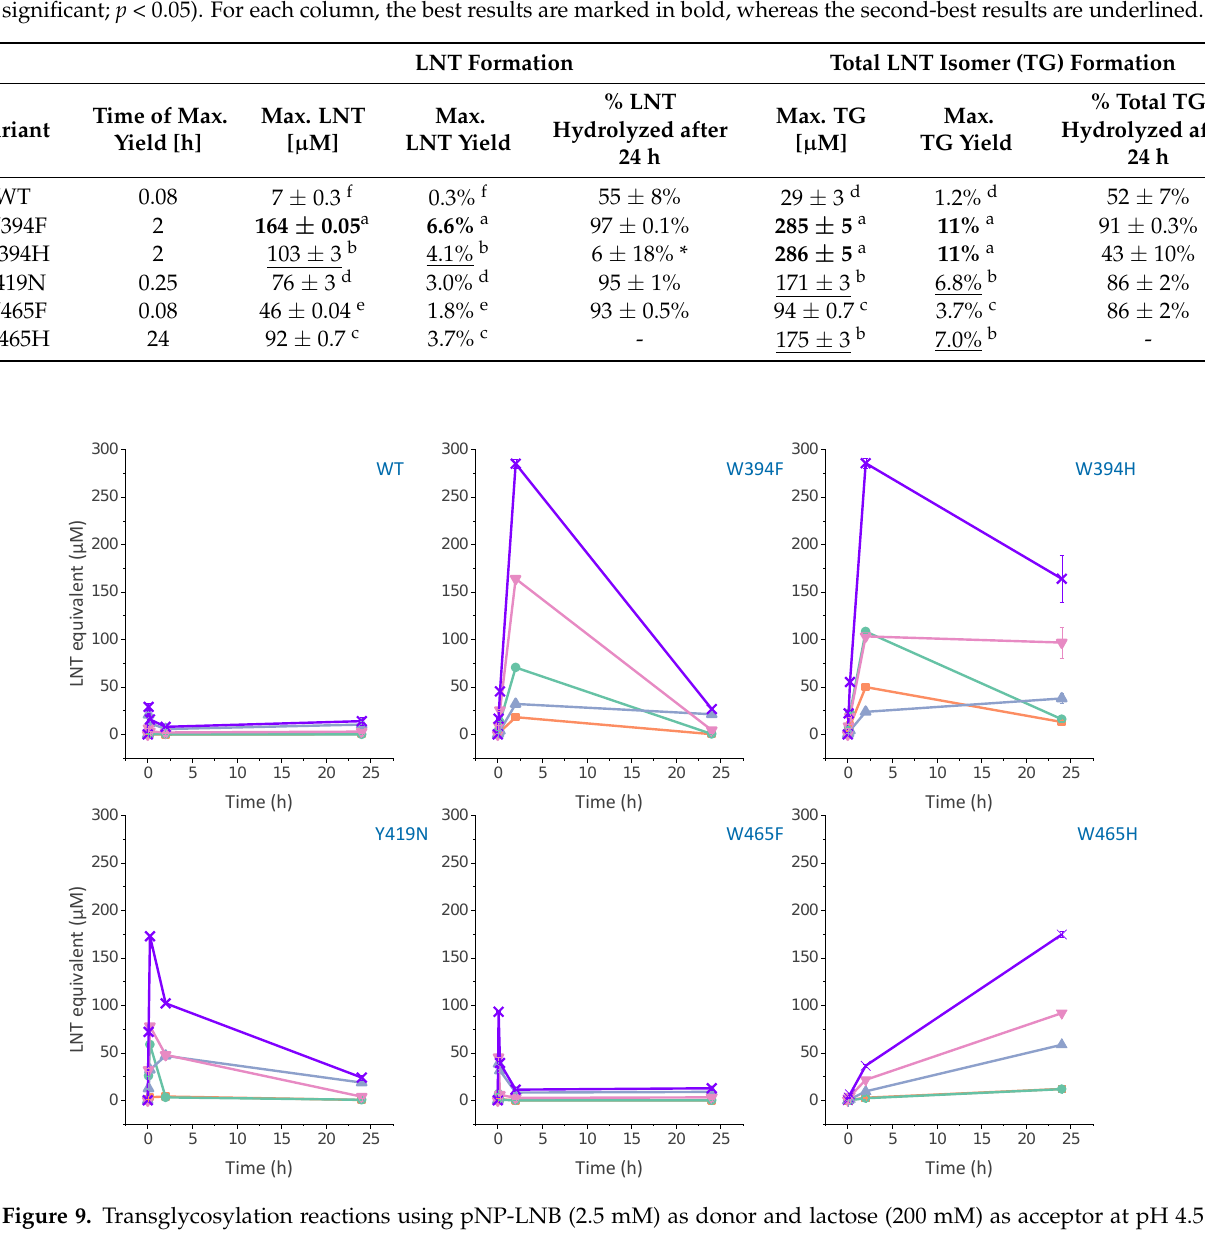
Table 2. Maximum yields of LNT and of LNT plus isomers (total transglycosylation products; TG) from transglycosylation reactions by LnbB WT and variants, using 2.5 mM pNP-LNB as donor, 100 mM lactose as acceptor, and 1 µ M of enzyme at pH 4.5 and 30 ◦ C. Superscript letters ( a–f ) indicate statistically significant difference between the values within the column ( p < 0.05). The time at which the maximum transglycosylation yields are reached is indicated (samples taken after 0.08,